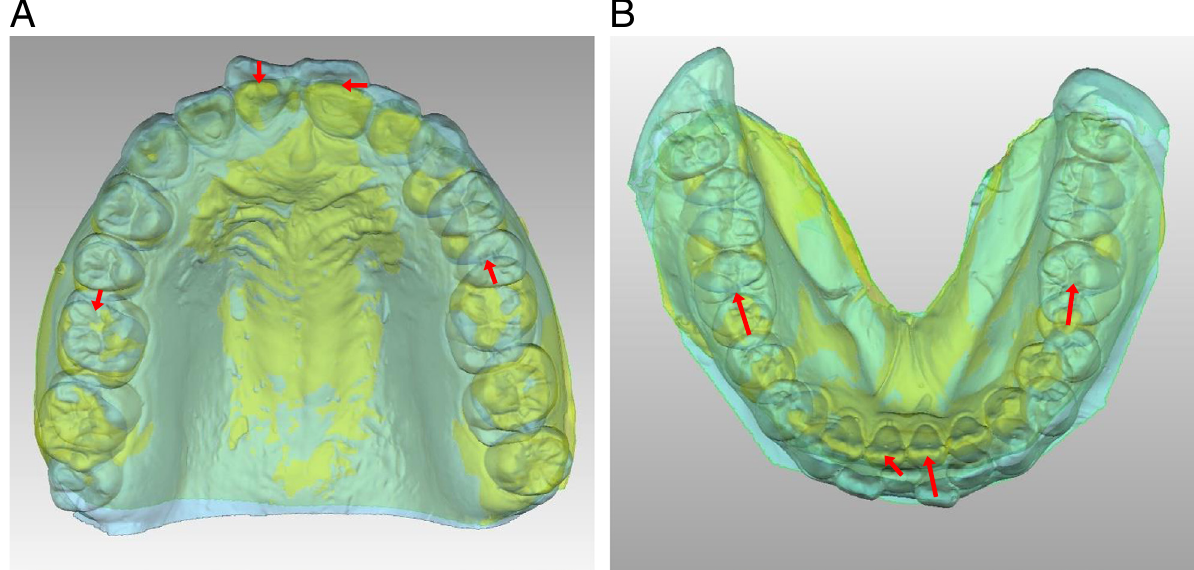
Figure 10. Superimposition of dental casts at pretreatment (light blue) and posttreatment (yellow-green) captured by a three-dimensional scanner. (A) The maxillary dental casts were superimposed at palate regions including the third palatal rugae. 13,14 (B) The mandibular dental casts were superimposed at the mandibular torus. 15 Red arrows indicate the movement of the upper and lower incisors and